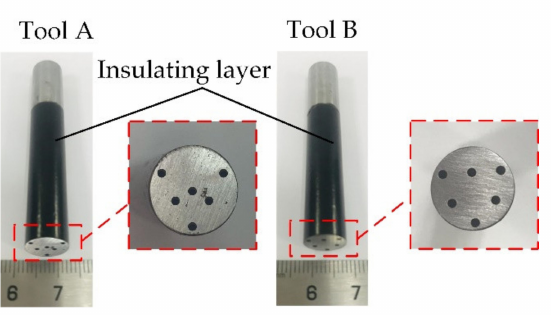
Figure 6. Photographs of tool A and tool B.